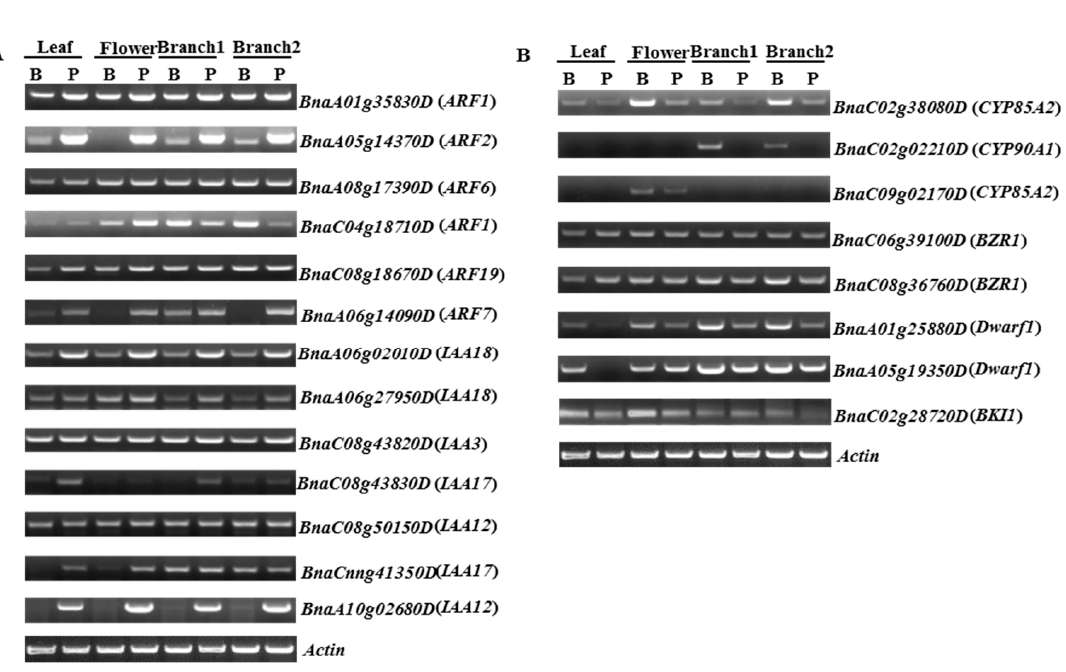
Figure 8. Validation of DEGs involved in ( A ) auxin signaling pathway and ( B ) BR signaling transduction and biosynthesis, by RT-PCR in 6098B (B) and Purler (P). Actin was amplified with 27 cycles, other genes were amplified with 34 cycles.